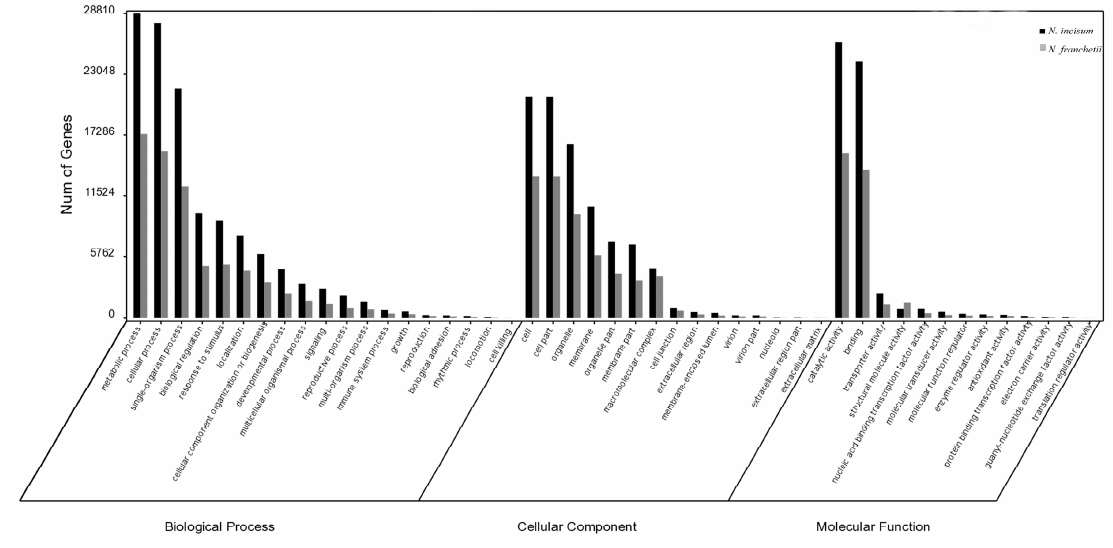
Figure 2. Gene Ontology (GO) distributions of unigenes.